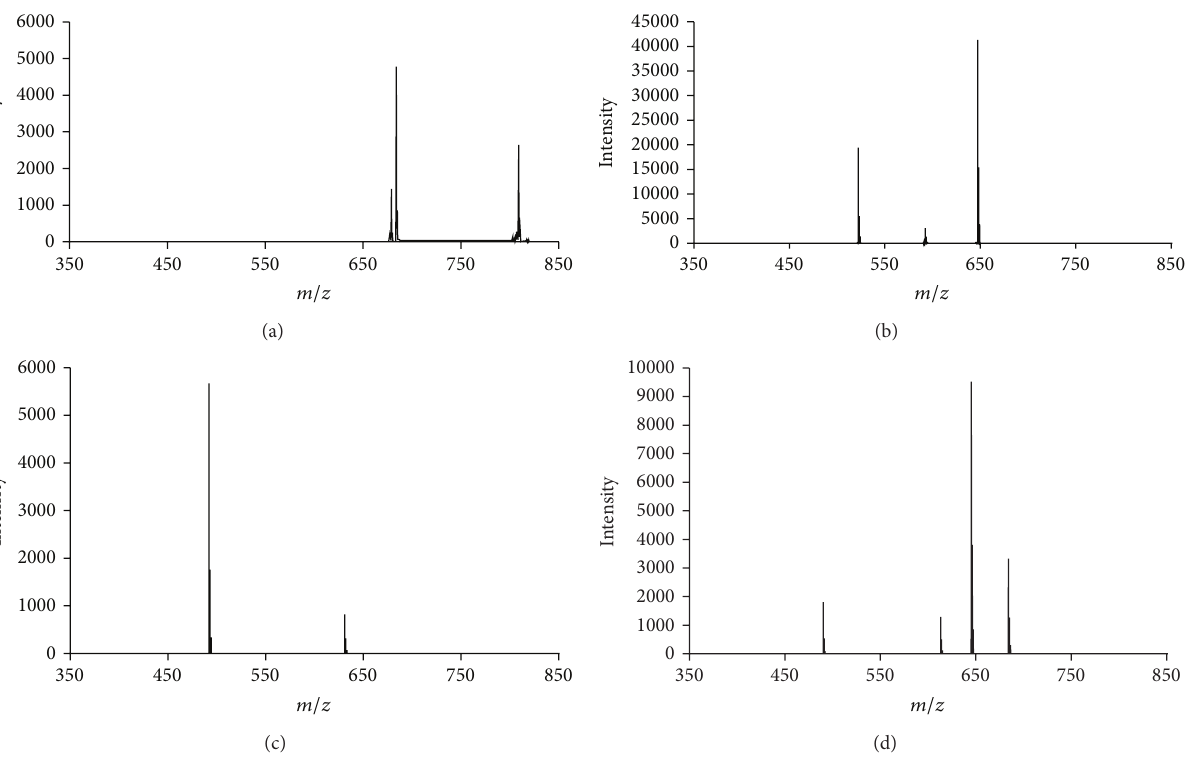
Figure 3: High performance liquid chromatography IT-MS 2 ion spectra of (a) Cl -NCC1 ( m / z 841.3), (b) Cl -NCC2 ( m / z 679.2), (c) Cl -NCC3 ( m / z 649.2), and (d) Cl -NCC4 ( m / z 807.3) in peels of lemon fruits extracts. Product ions are detailed in Table